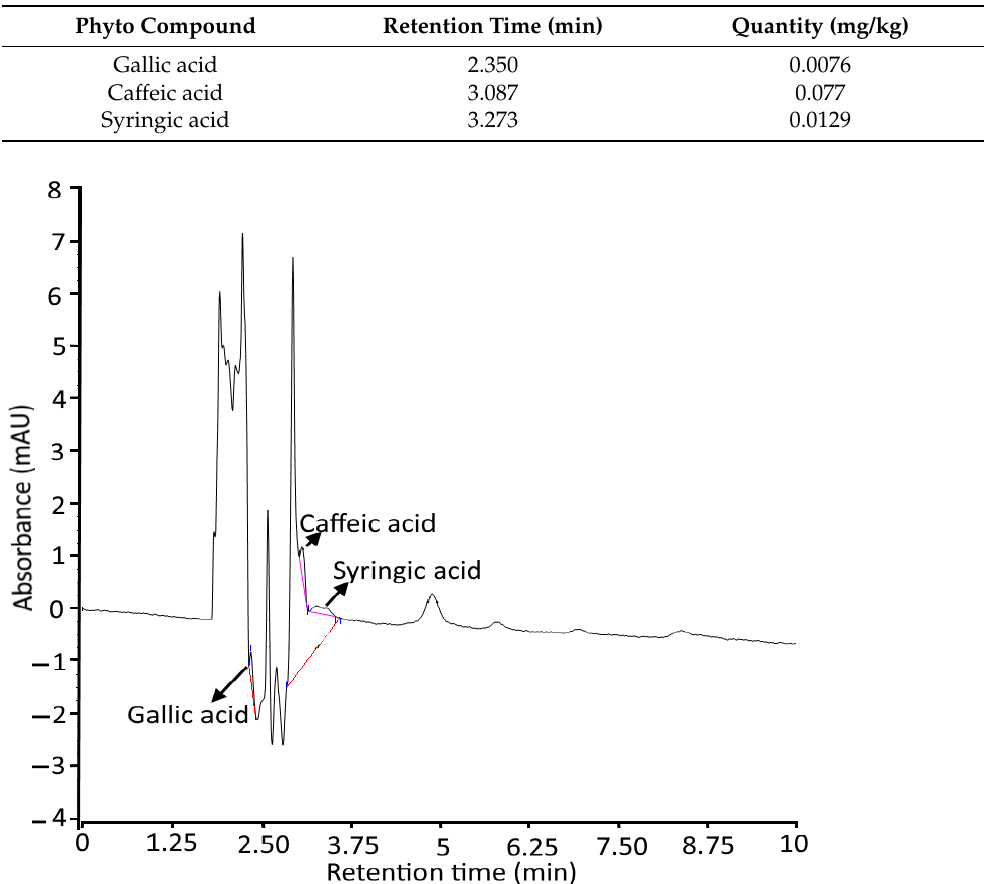
Figure 2. HPLC chromatogram representing quantitative analysis of gallic acid, caeffic acid, and syringic acid in Azadirachta indica oil. Table 2. Quantification of phytocompounds by HPLC analysis.